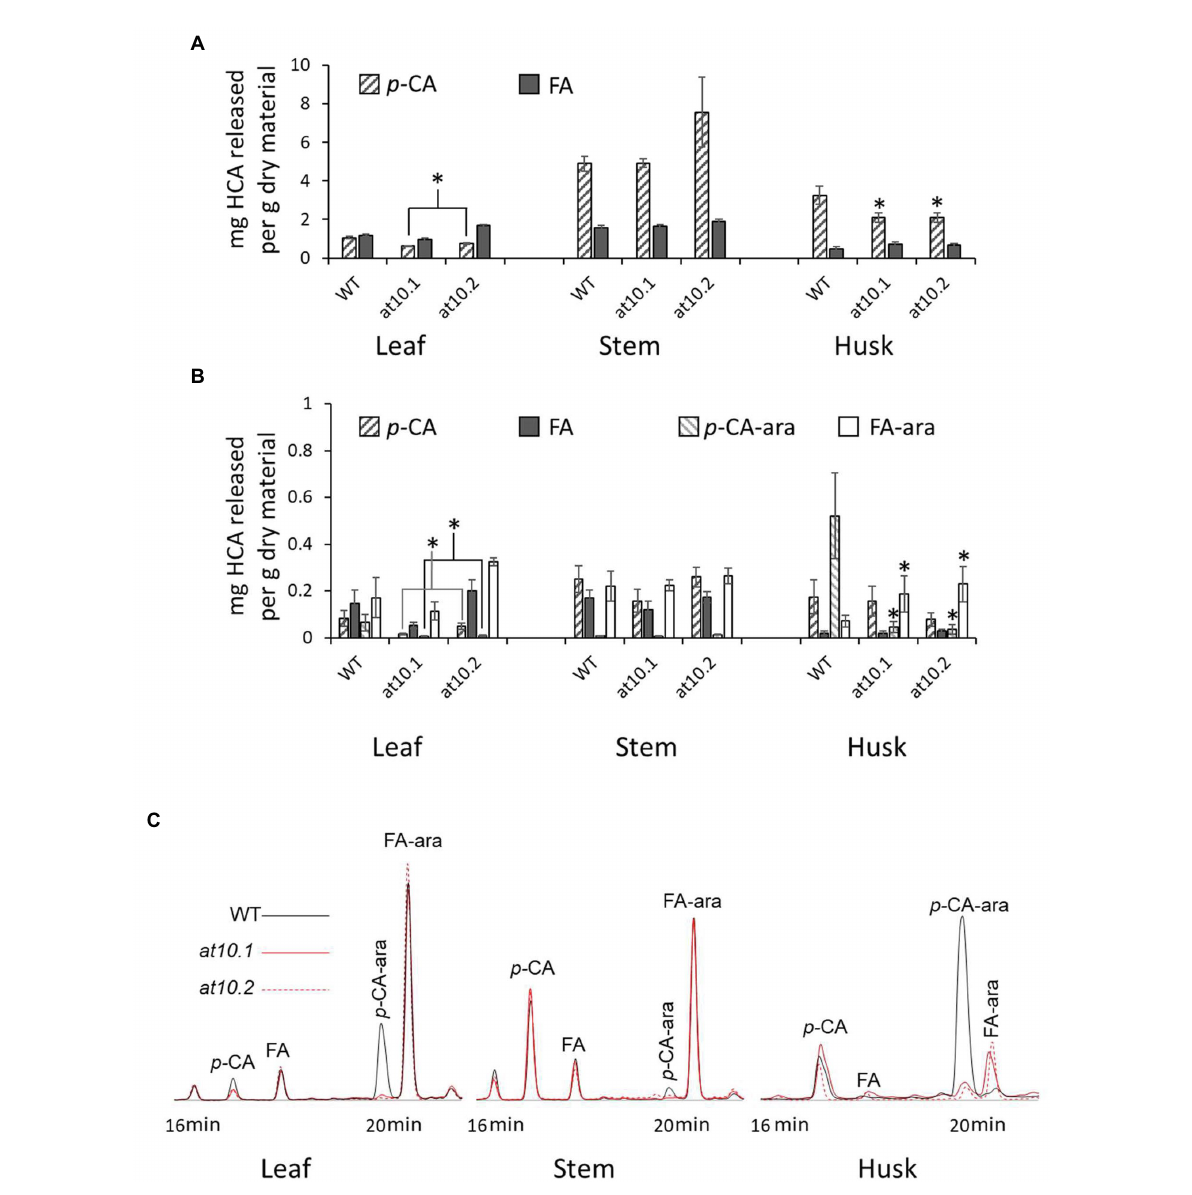
FIGURE 3 Hydroxycinnamic acids contents and identification in Osat10 . (A) Determination of total ester-linked ferulic acid (Grey bars) and p -coumaric acid (Hatched bars) content of stems, leaves and husks as obtained from alkaline hydrolysis per gram of dry material. (B) HPLC-UV determination of p -CA (Hatched bars), FA (Grey bars), p -CA-ara (Hatched bars, lighter) and FA-ara (White bars) released by mild acidolysis of rice leaves, stems and husks from OsAT10.1, OsAT10.2 and WT. Error bars represent standard deviation. * Significant difference at p < 0.05 via Student’s t test. (C) HPLC chromatograms from leaves, stems and husks, showing UV absorption at 320 nm. Wild type is black OsAT10.1 is red and OsAT10.2 is dotted. Compounds: p -CA-ara; methyl 5-O-E- p -coumaroyl-L-arabinofuranoside, FA-ara; methyl 5-O-E-feruloyl-L-arabinofuranoside, FA; Ferulic acid, p -CA; p -Coumaric